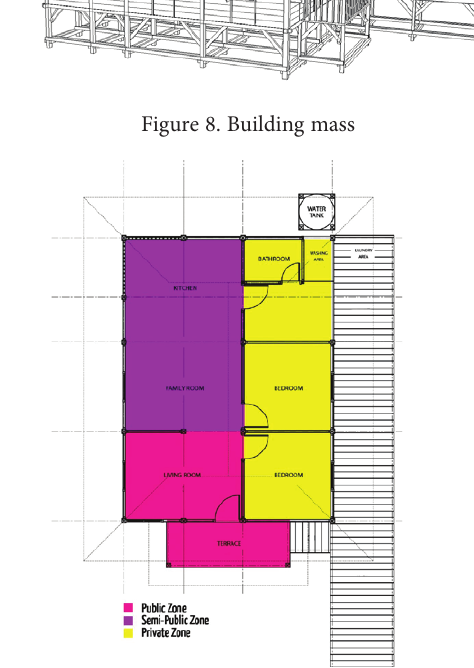
Figure 9. Zoning diagram